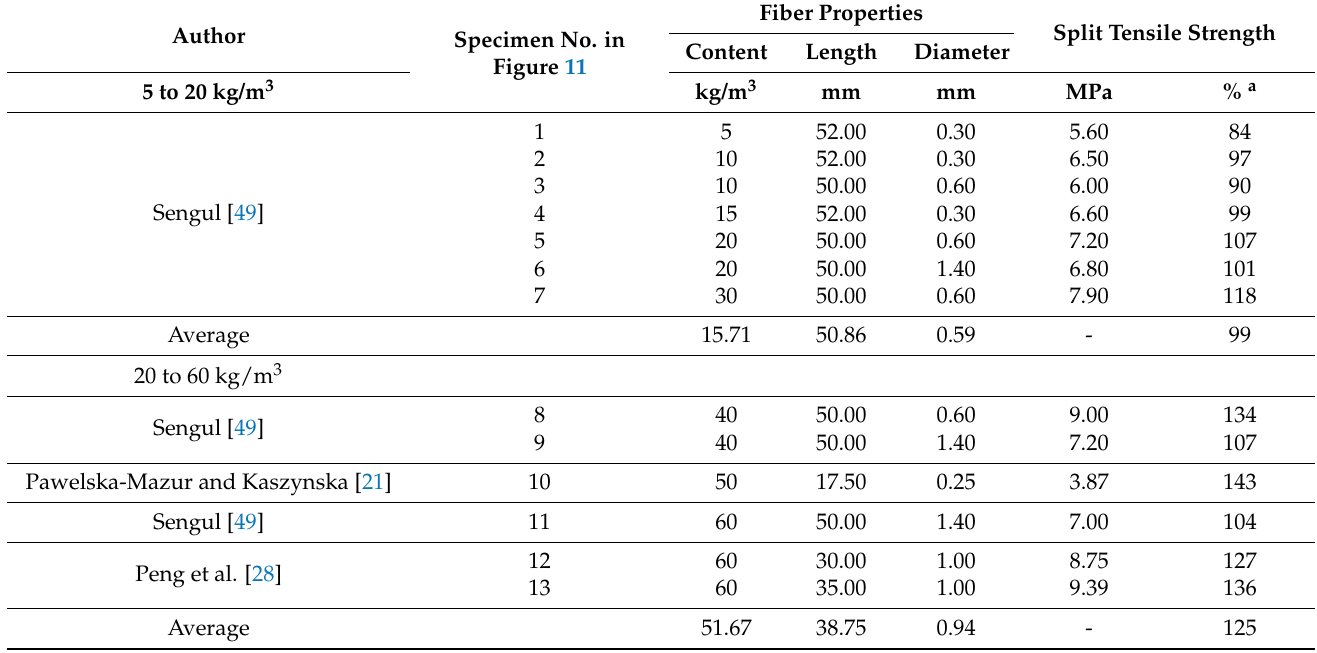
Table 8. Results of split tensile strength’s percent comparison and fiber properties of the concrete incorporating RSF in kg/m 3 .